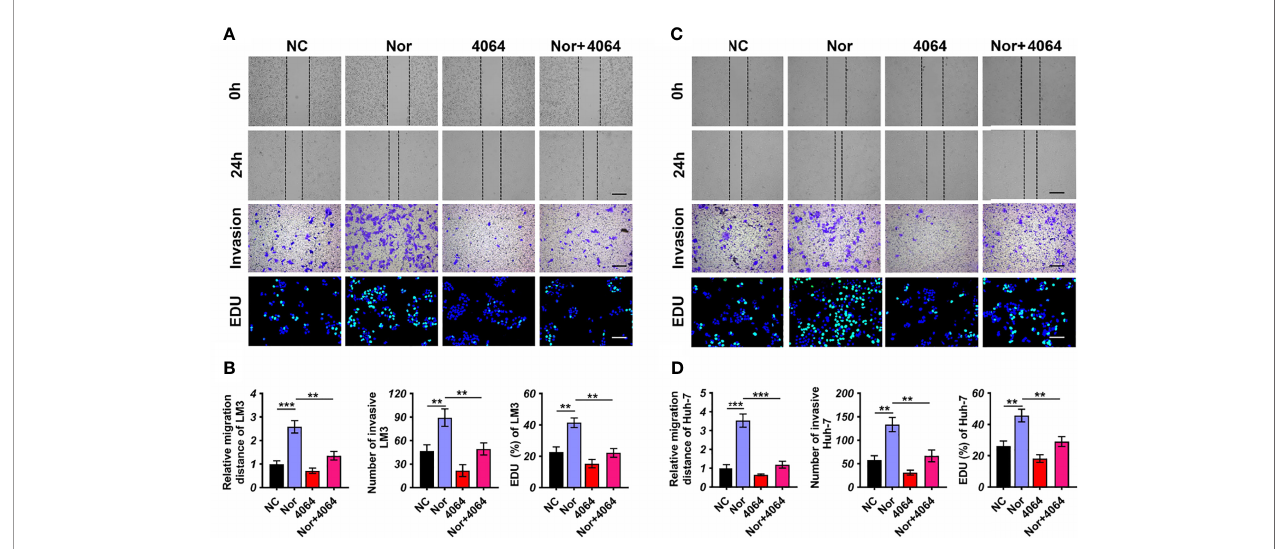
FIGURE 2 | NorCA enhances the ability of HCC cells to migrate and invade and promotes cell proliferation. (A-D) Data showed that after NorCA exposure, the migration and invasion abilities of Huh-7 cells and LM3 cells were enhanced, while the FXR agonist GW4064 restored these trends (scale bar, 100 µm). EdU assay showed the consistent results (scale bar, 100 µm). **p < 0.01, and ***p < 0.001, n = 3. Cells treated with BSA were used as a negative